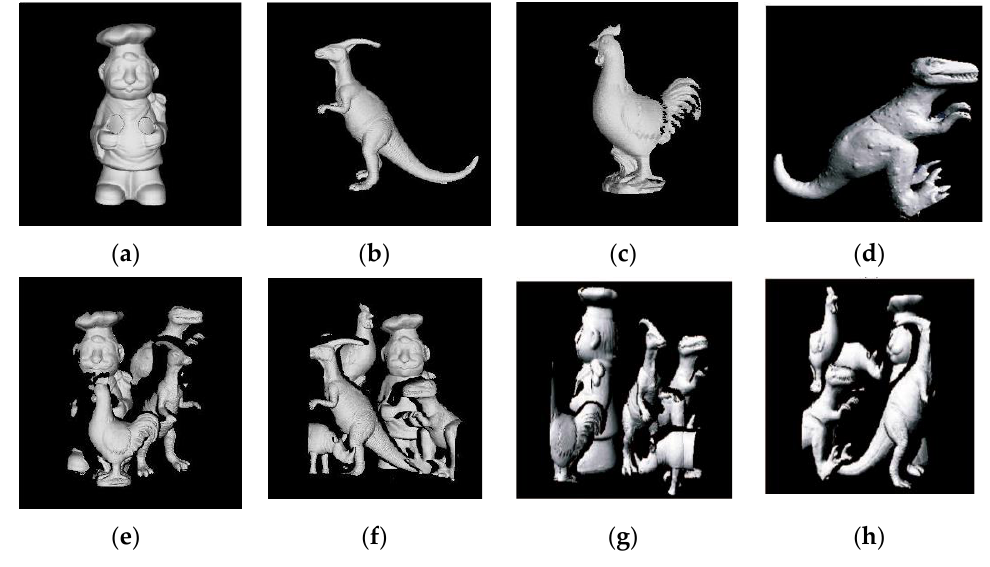
Figure 5. UWA object model and four random scenarios in the dataset, ( a ) Chef; ( b ) Parasaurolophus; ( c ) chicken; ( d ) T-rex; ( e – h ) four random scenes.